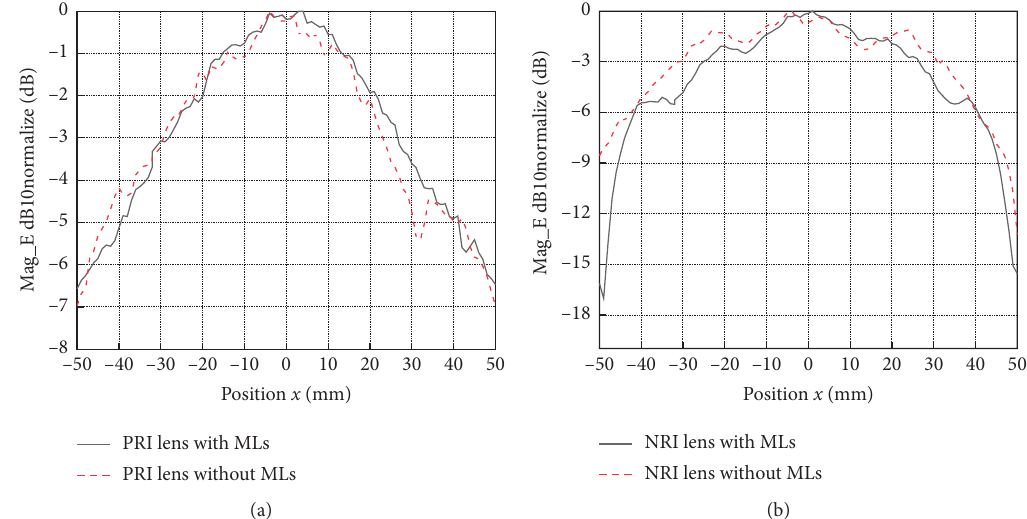
Figure 11: Electric field amplitude distributions on the aperture planes. (a) PRI lens with and without MLs. (b) NRI lens with and without